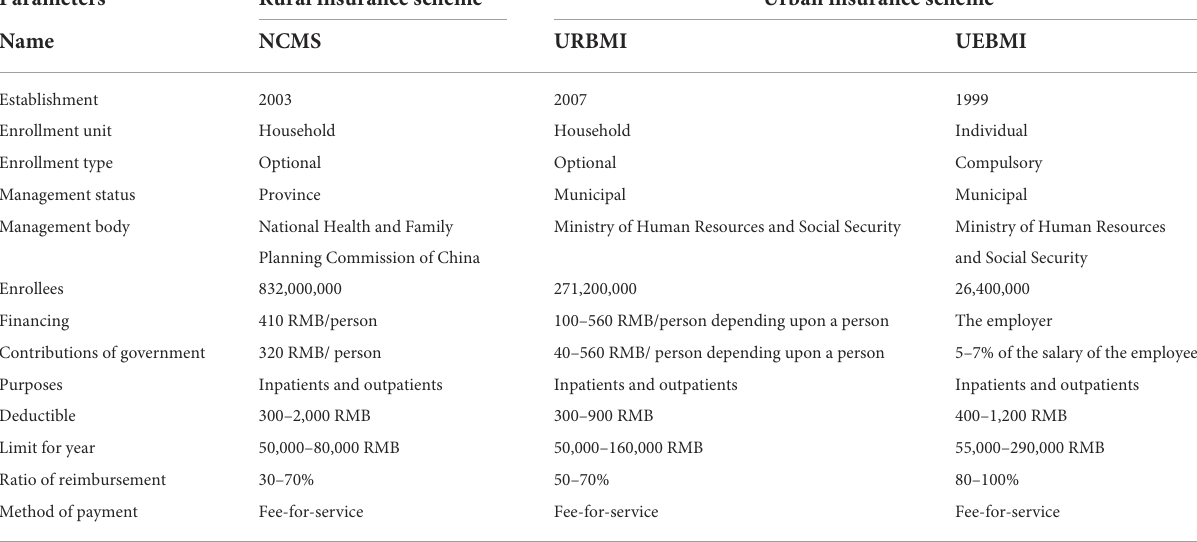
TABLE 1 The overview of the existing public health insurance scheme of China